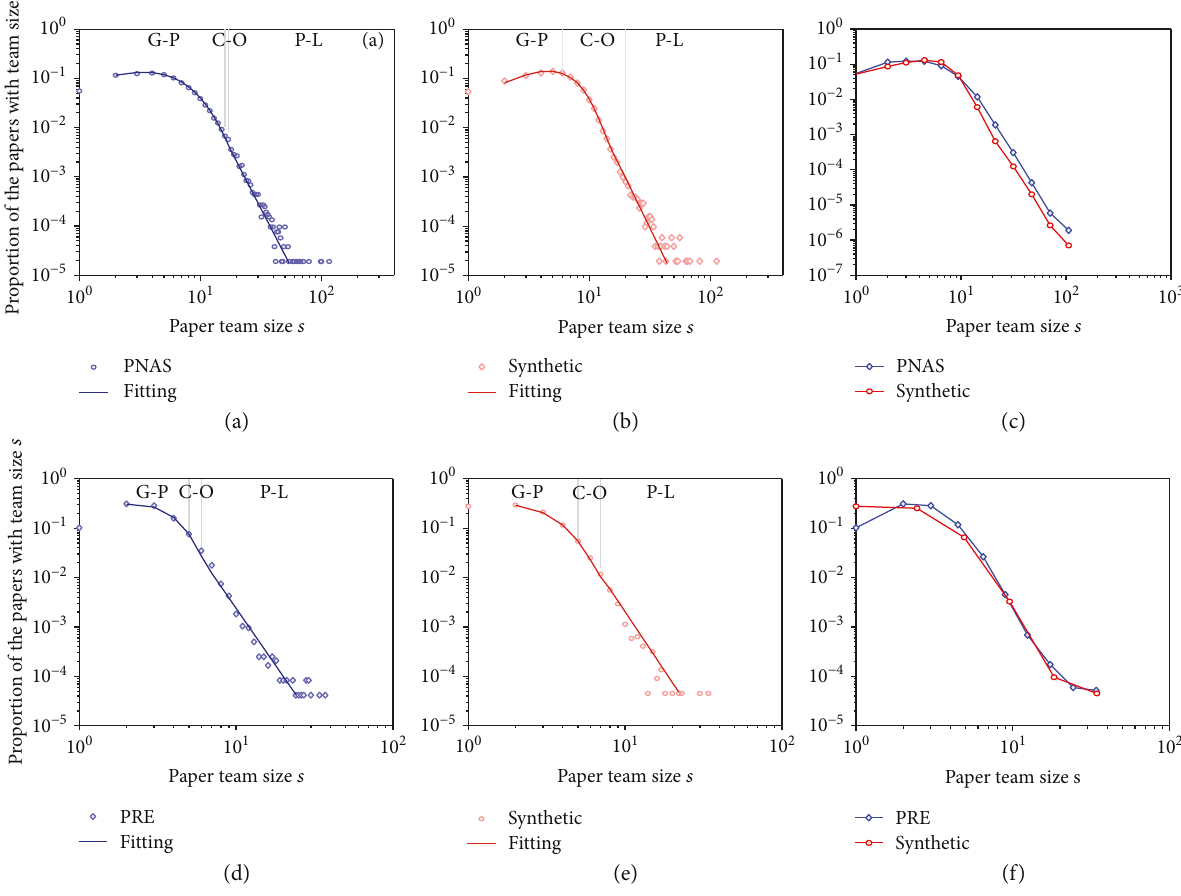
Figure 3: The distributions of sizes per paper team. In the panels of the fi rst two columns, the regions “ G-P, ” “ C-O, ” and “ P-L ” stand for generalized Poisson, crossover, and power law, respectively. The parameters and goodness of fi ttings are listed in Table